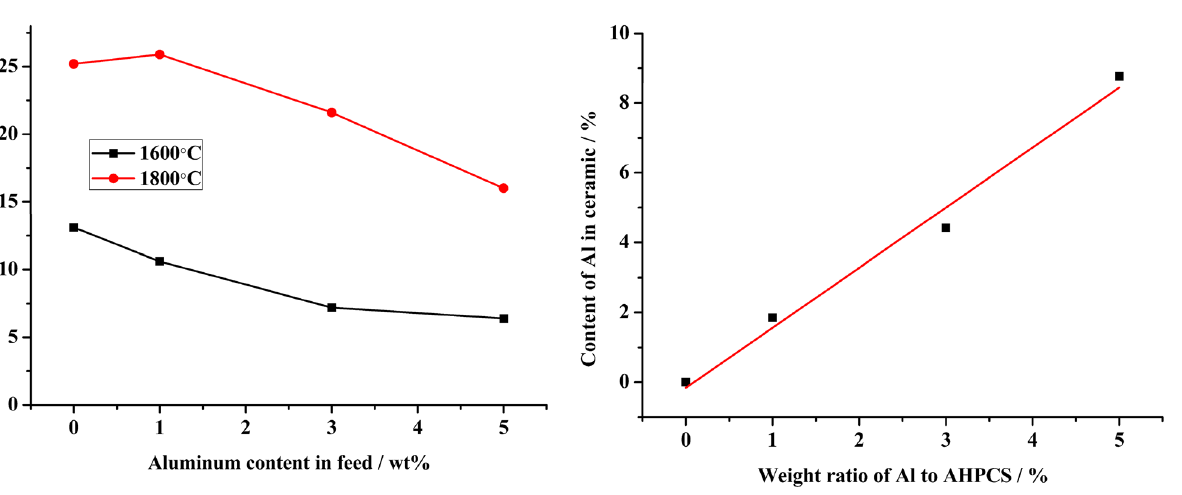
Figure 14: Dependence of Al content in 1,600°C ceramics on Al content in PACS